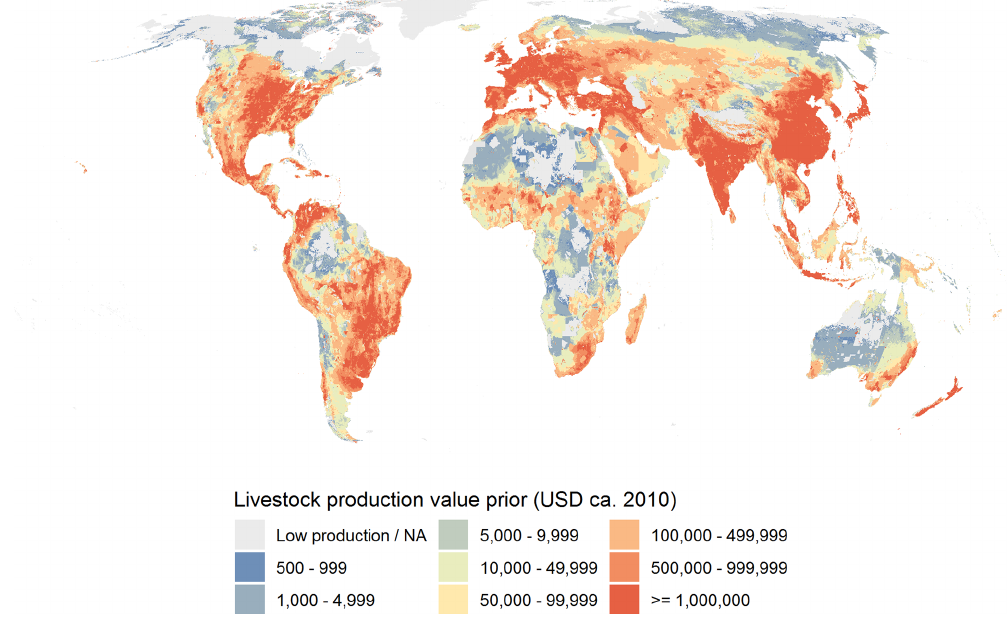
Figure 2. The assembled livestock production value used as a prior in the cross-entropy model. Sources: Robinson et al. (2014); Gilbert et al. (2018); Eurostat